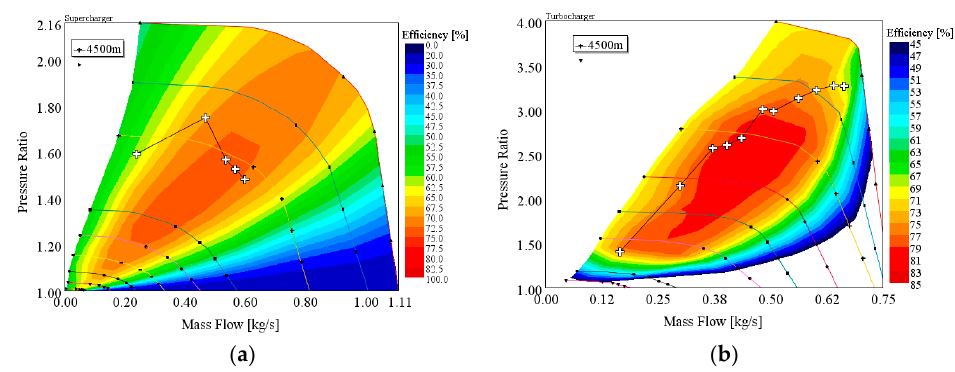
Figure 7. Full load optimization results. ( a ) Supercharger; ( b ) Turbocharger.